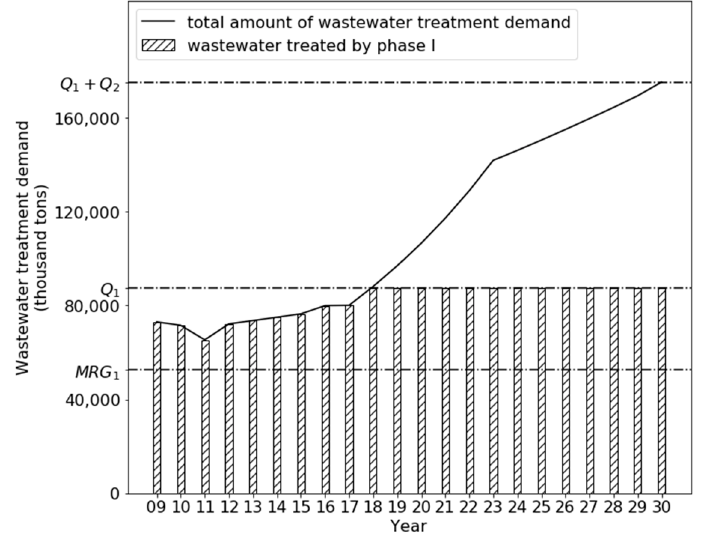
Figure 3. Wastewater quantity in the Xin’an and Xixiang areas. Table 4. Wastewater treatment demand in the Xin’an and Xixiang areas.